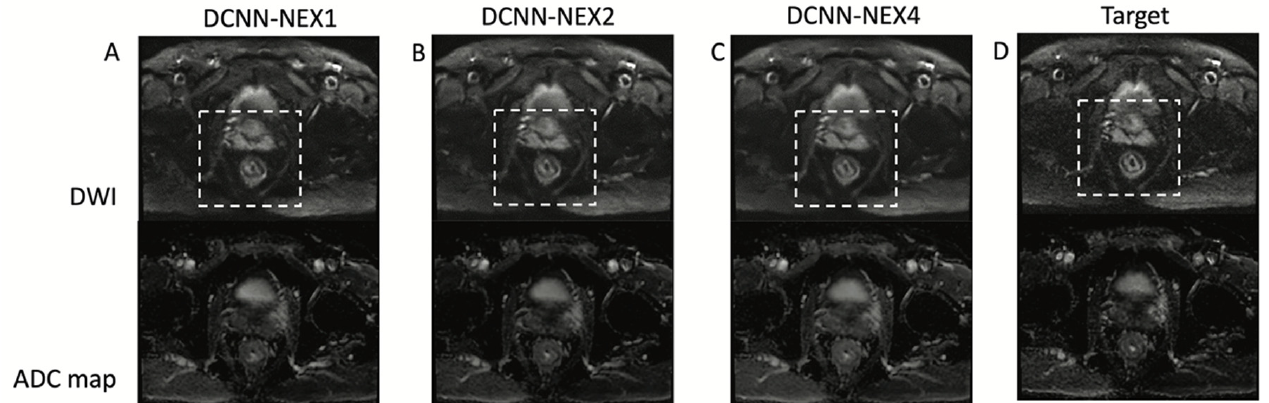
Figure 5. DCNN for different acceleration factors or a number of repetitions (NEX). DCNN results for NEX = 1 or 16-fold acceleration ( A ), NEX = two or eightfold acceleration ( B ) and NEX = four or fourfold acceleration ( C ). The dashed square shows the rectal area. The reference high b -value image ( D ) is shown for comparison purposes. DCNN presents high-performance denoising for all cases with a slight improvement for the case of NEX = 4.